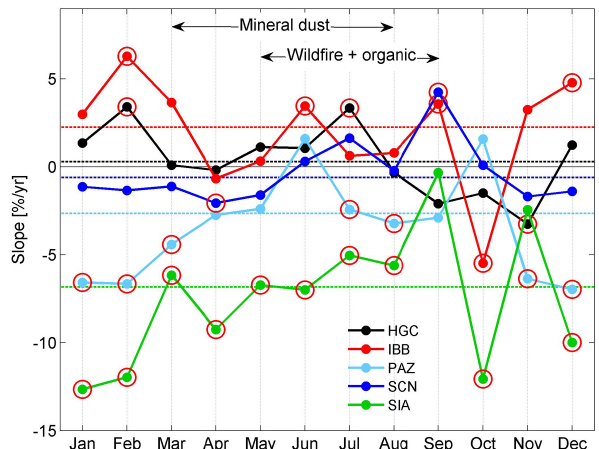
Fig. 9. Seasonal Mann-Kendall trend analysis for the scattering co- efficients of southwestern US (Arizona) stations. The symbols have the same meaning as in Fig.